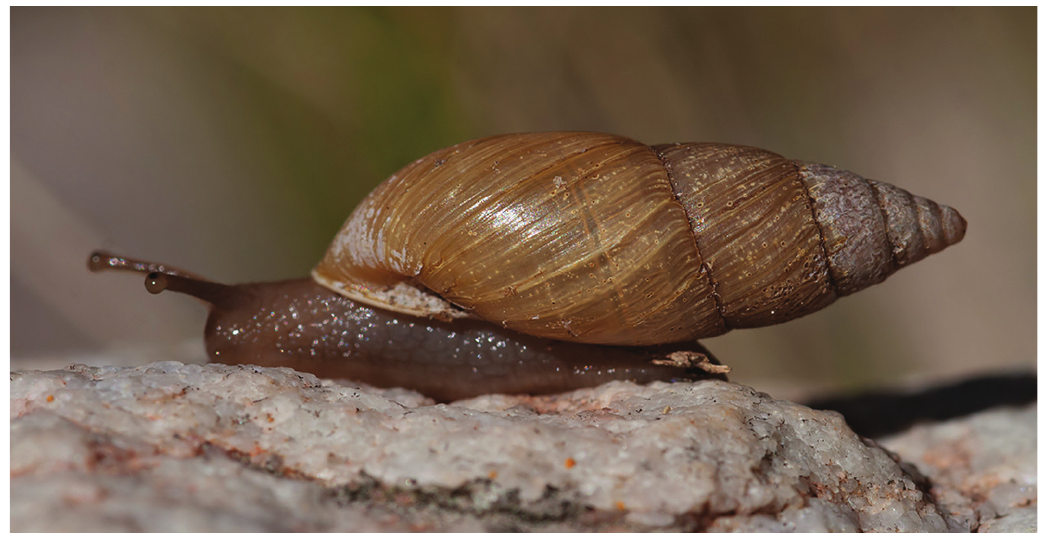
Figure 2. Living specimen of Ventania avellanedae showing erosion in adult shells, umbilicus and peristome slightly reflexed.